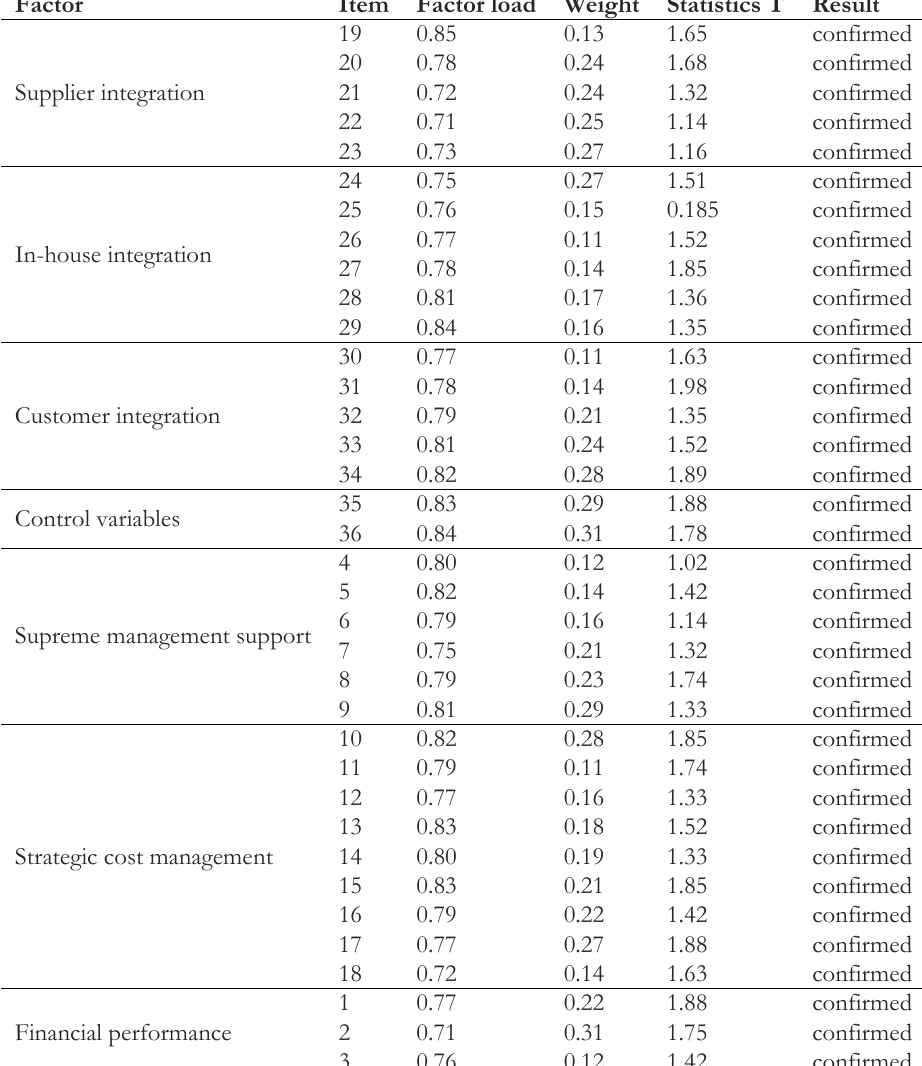
Table 2. Fit indicators the estimated